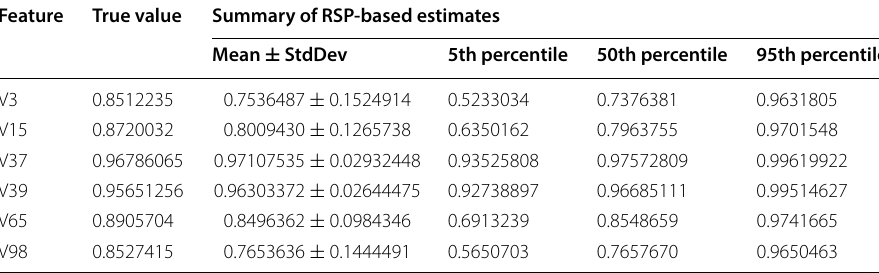
Table 6 Correlation between V38 and 6 other features in Power data Feature True